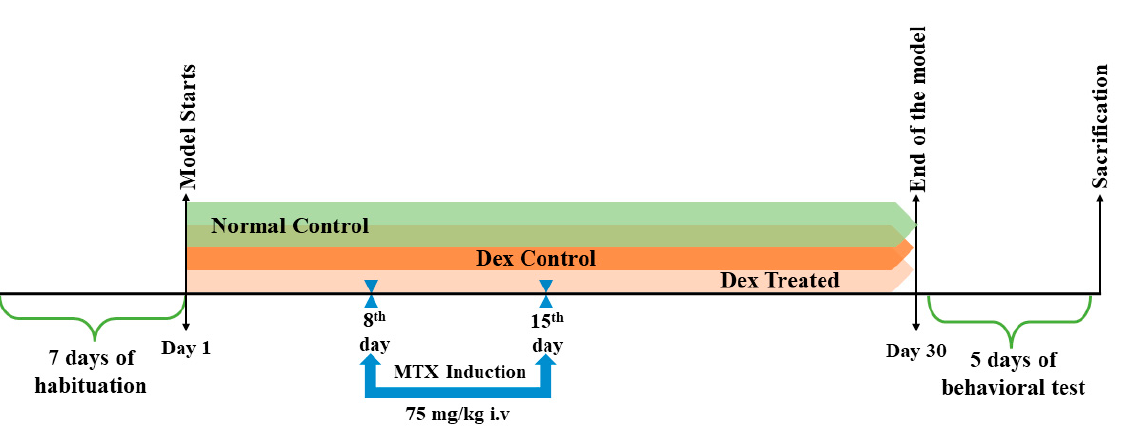
Figure 9. Experimental model timeline. Schematic presentation of the experimental design. Group